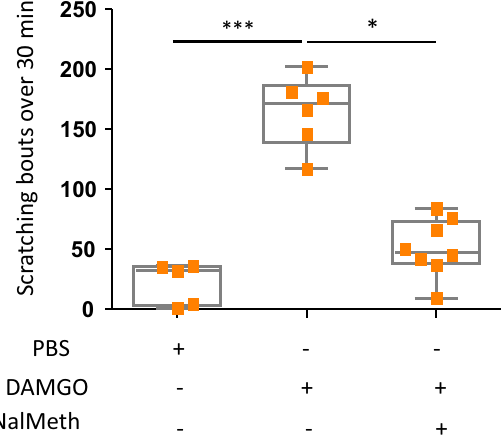
Figure 1. Scratching behavior induced by DAMGO is suppressed by a pre-treatment with naloxone- methiodide. Scratching bouts evoked by intradermal injections of either PBS (n = 5) or DAMGO (200 µ M) in the nape of the neck 30 min after a pre-treatment with PBS (n = 6) or naloxone methiodide (1 mg/Kg, s.c, n = 8)). Results are represented as Whisker-dot plot (Min-Mean-Max) and each symbol represents an individual mouse. Statistical analysis were performed using Kruskall-Wallis followed by post-hoc Dunn’s test ( *** p < 0.01 WT + DAMGO versus WT + PBS and * p < 0.05 represents WT + DAMGO versus NAL +